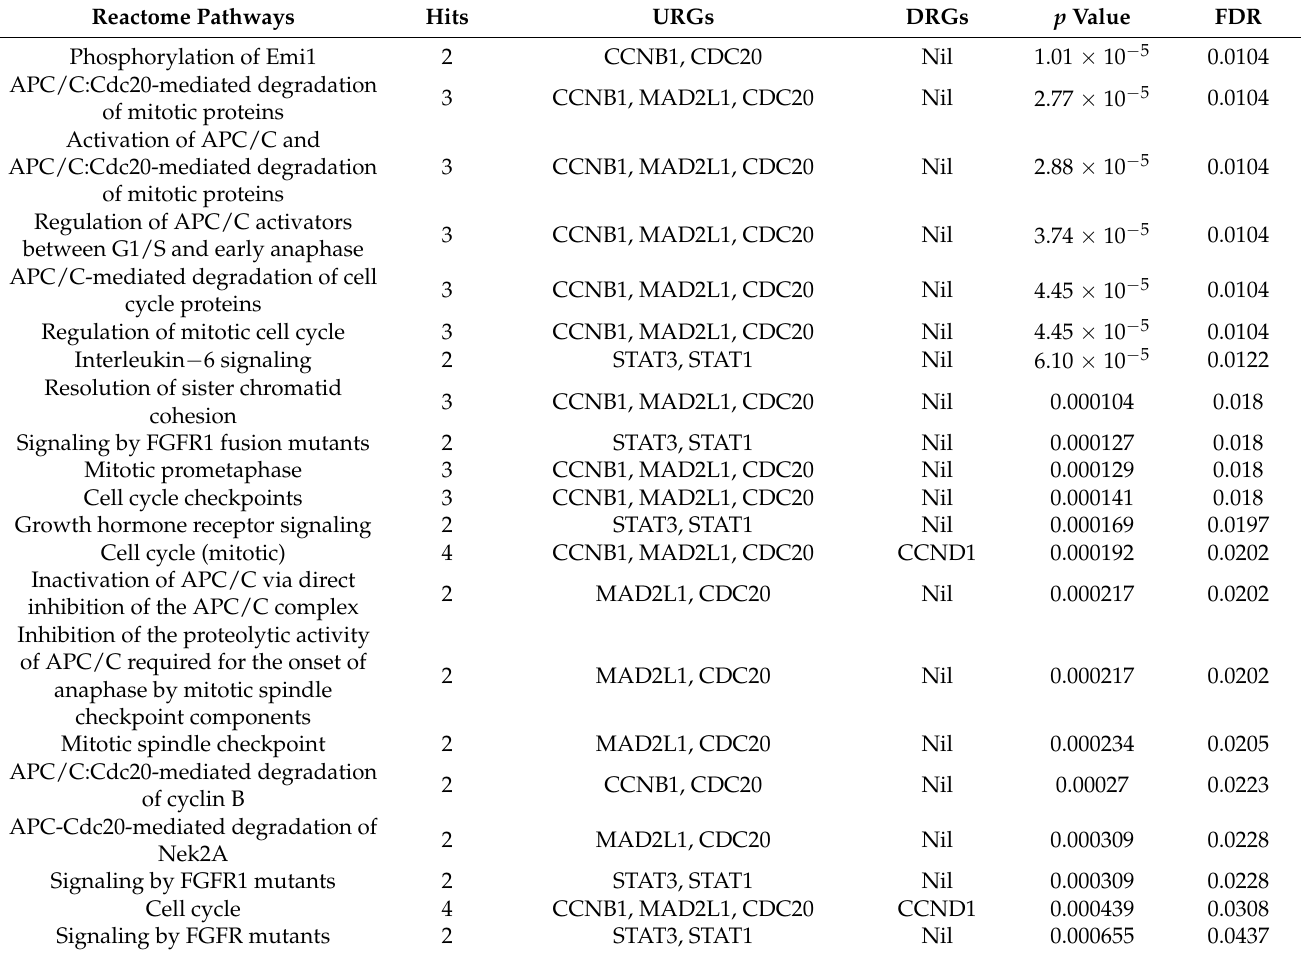
Table 5. Annotation of hub genes in